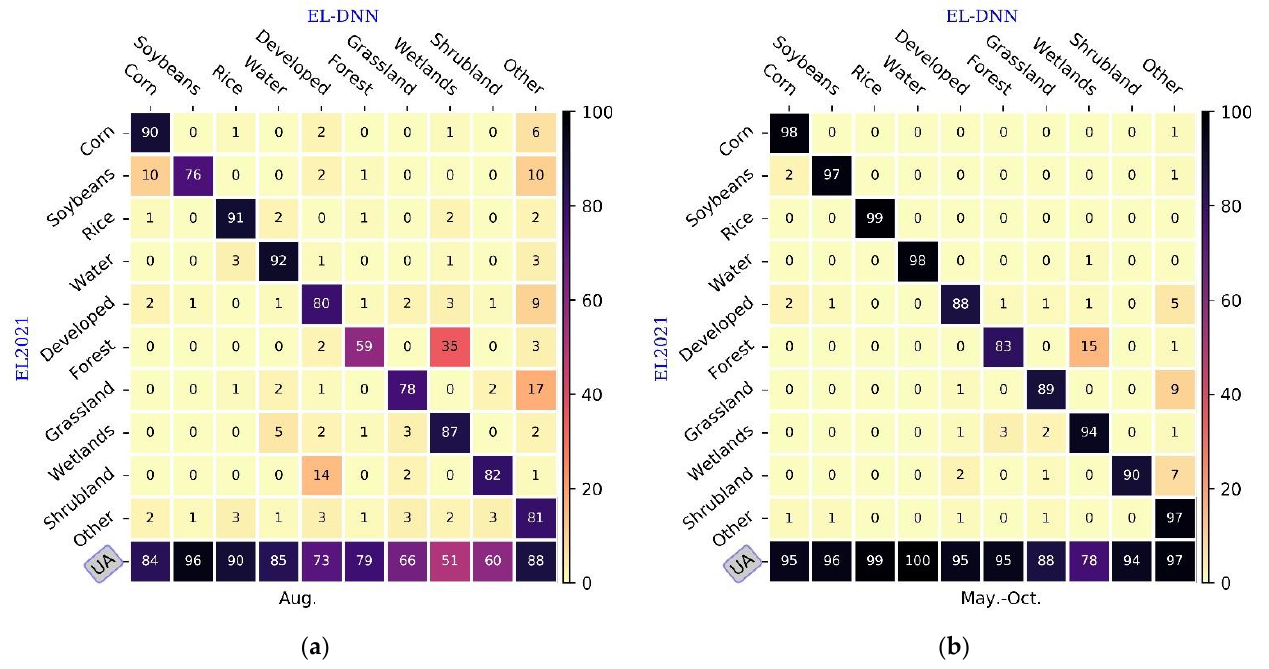
Figure 5. Normalized confusion matrix on the test data set (EL2021). ( a ) August; ( b ) May to October.